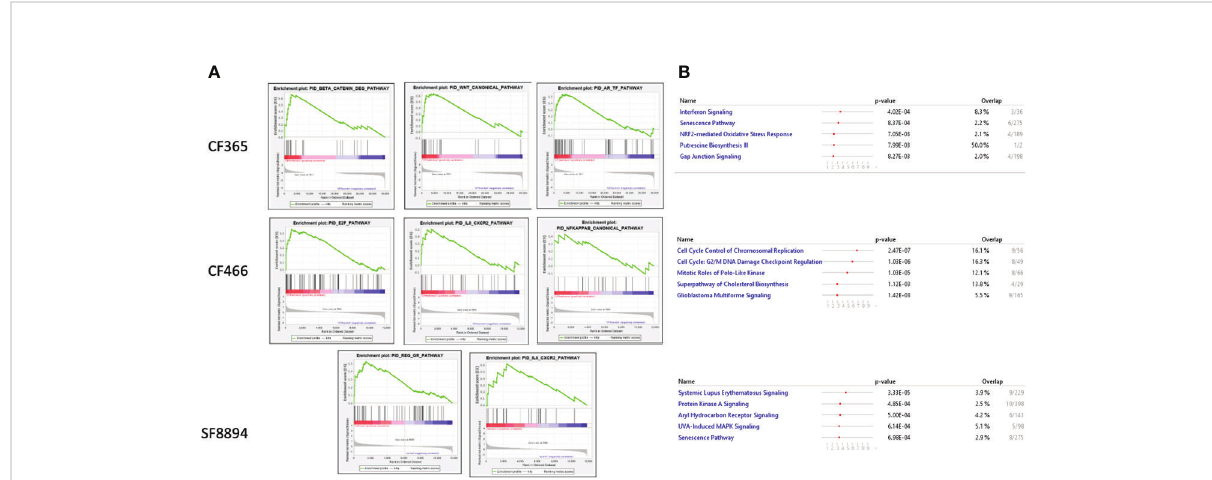
FIGURE 5 Top altered pathways in selinexor treated tumors. (A) Heatmaps of gene set enrichment analysis (GSEA) show altered disease and function pathways and sub-pathways in CF466, SF8894 and CF365 xenografts treated with selinexor. Size of individual boxes are inversely proportional to P-value. Color is according to z-score. Produced using Ingenuity Pathway Analysis software. (B) IPA analysis of top modi fi ed pathways; top panel, CF365; middle panel, CF466; bottom panel,